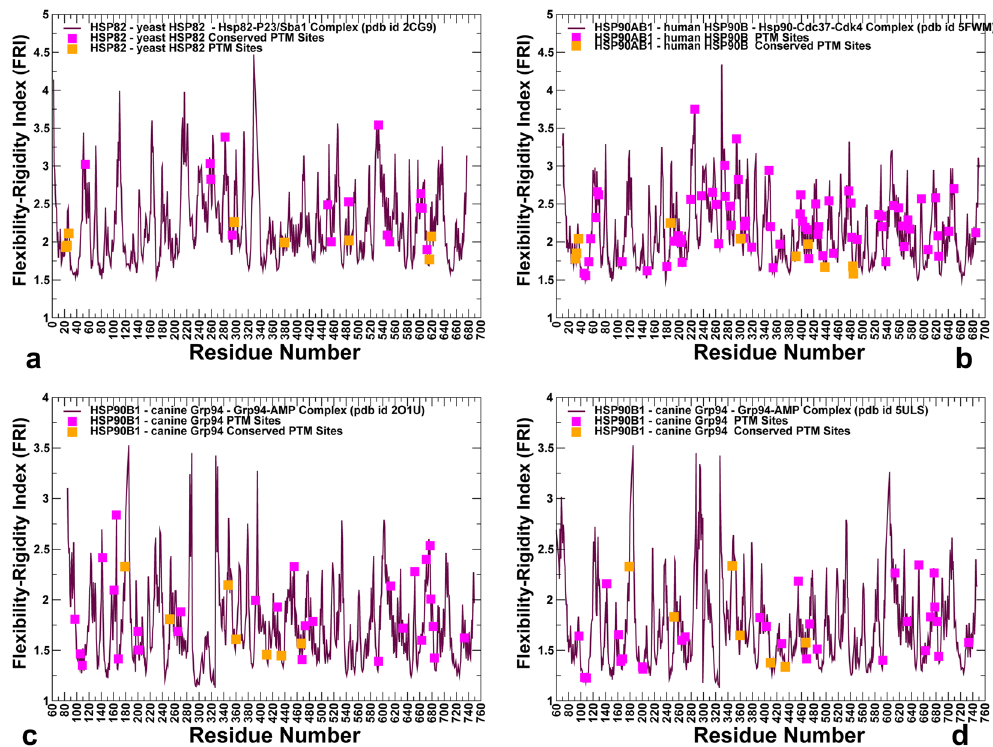
Figure 5. Conformational Mobility Analysis of the Hsp90 Proteins: Flexibility-rigidity FRI Profiles. The ensemble-based average FRI profiles are generated from the equilibrium DMD trajectories for structures of the yeast Hsp82 ( a ), human Hsp90 β ( b ), and two different structures of canine Grp94 ( c , d ). The FRI values for PTM sites are shown filled magenta squares along the profiles and evolutionary conserved PTM sites are annotated in filled orange